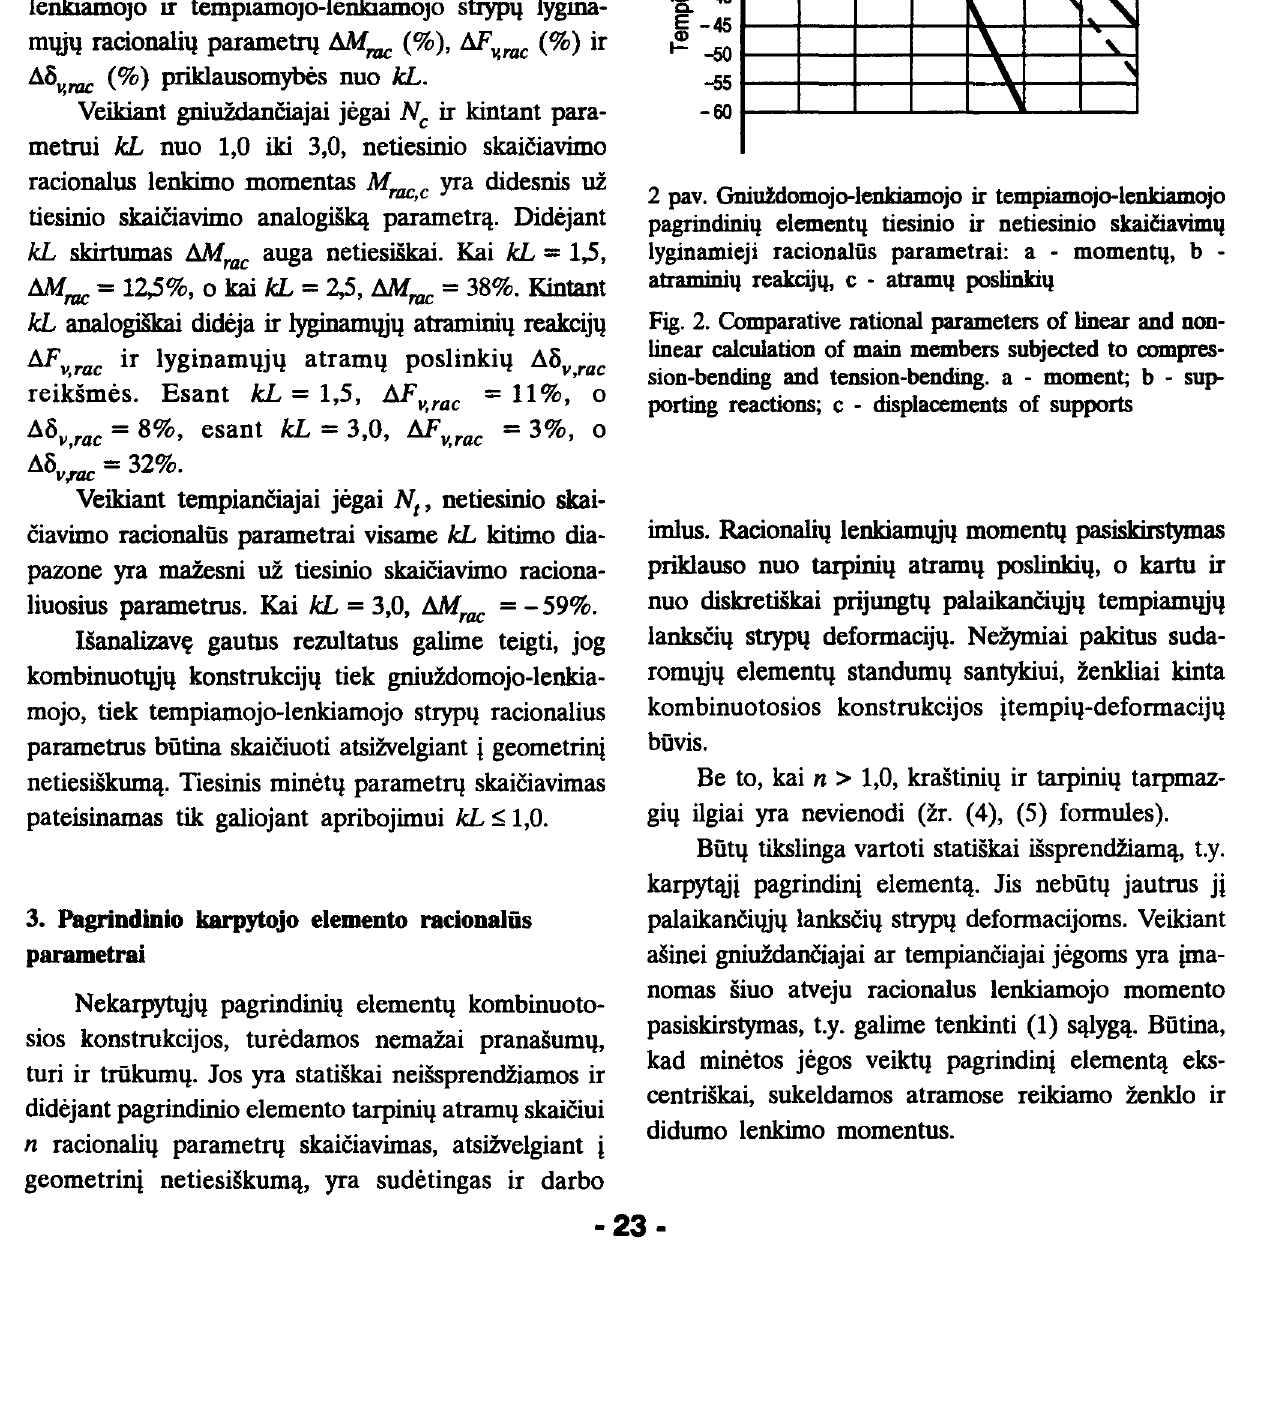
Fig. 2. Comparative rational parameters of linear and non linear calculation of main members subjected to compres sion-bending and tension-bending. a - moment; b - sup porting reactions; c - displacements of supports